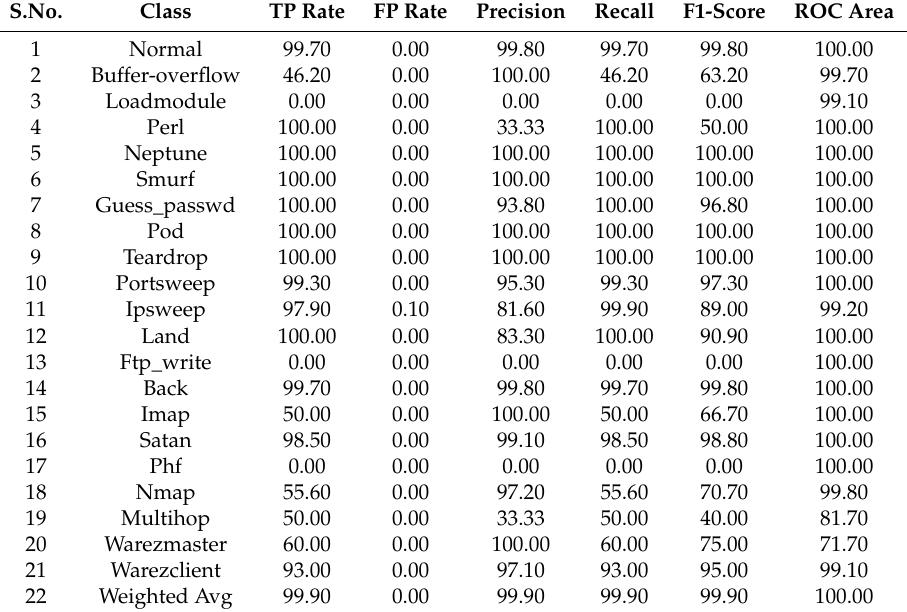
Table 21. Multiclass classification report for KDD99 using Adaboost